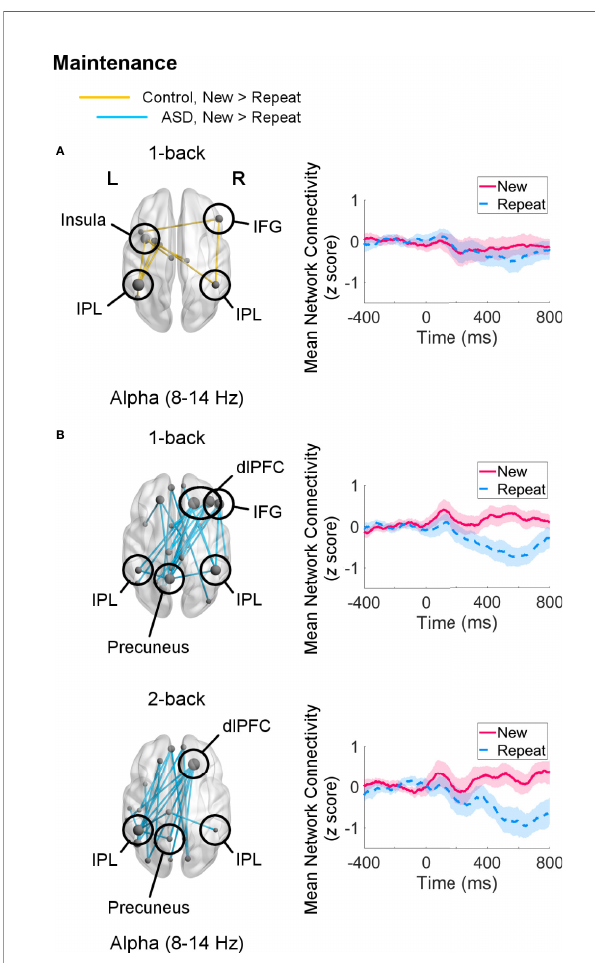
FIGURE 4 | Networks showing increased connectivity during maintenance of novel visual stimuli (New versus Repeat trials, 400 – 800 ms, poststimulus onset) during the 1-back and 2-back loads (left) and mean connectivity of these networks between − 400 – 800 ms (right). Node size is scaled by number of connections. Connectivity values are given as z scores. (A) Control adults showed recruitment of a network in the alpha band in the 1-back load ( p FWE = 0.048), but not in the 2-back load. (B) Adults with autism spectrum disorder (ASD) displayed greater connectivity in a network in the alpha band similar between the 1-back ( p FWE = 0.001) and 2-back ( p FWE = 0.002) samples.